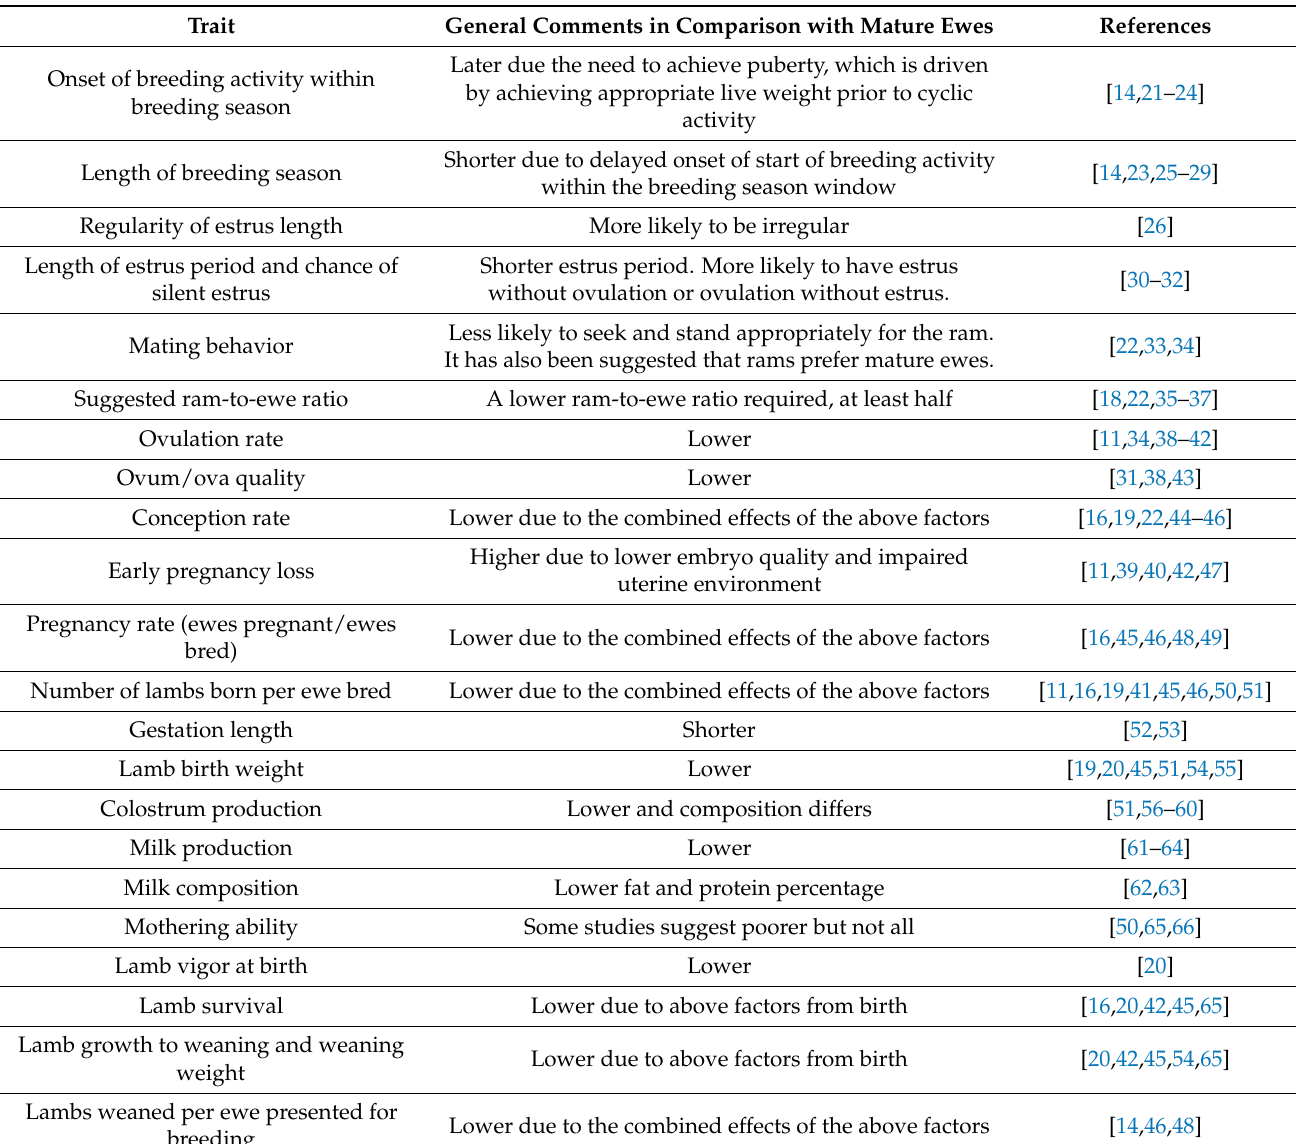
Table 1. Comparison of ewe lamb and mature ewe reproductive traits. Trait General Comments in Comparison with Mature